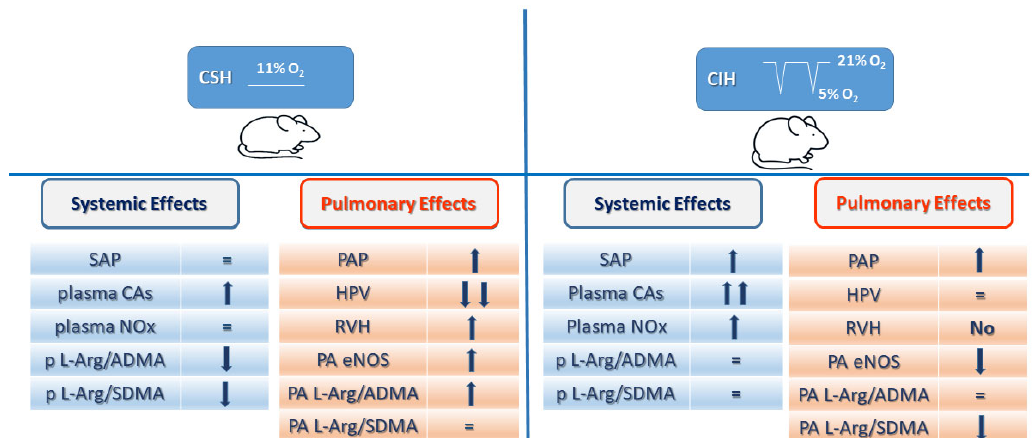
Figure 7. Schematic figure representing the main findings on systemic and pulmonary effects in rats exposed to CSH ( left ) and CIH ( right ) vs. Control rats. SAP: systemic arterial pressure; CA: catecholamine; NOx: Nitrites; ADMA: asymmetrical dimethyl-L-arginine; SDMA: symmetrical dimethyl-L-arginine; PAP: pulmonary arterial pressure; HPV: hypoxic pulmonary vasoconstriction; RVH: Right ventricular hypertrophy (Fulton index); PA: pulmonary arteries; p = plasma. The clinical consequences of chronic hypoxia with sustained alveolar hypoxia, which occurs in COPD and other respiratory disorders, include maladaptive responses such as polycythemia, weight loss, PH, right ventricular hypertrophy (RVH), and an increased amount of smooth muscle cells (SMCs) in the distal pulmonary arterial branches. Animal